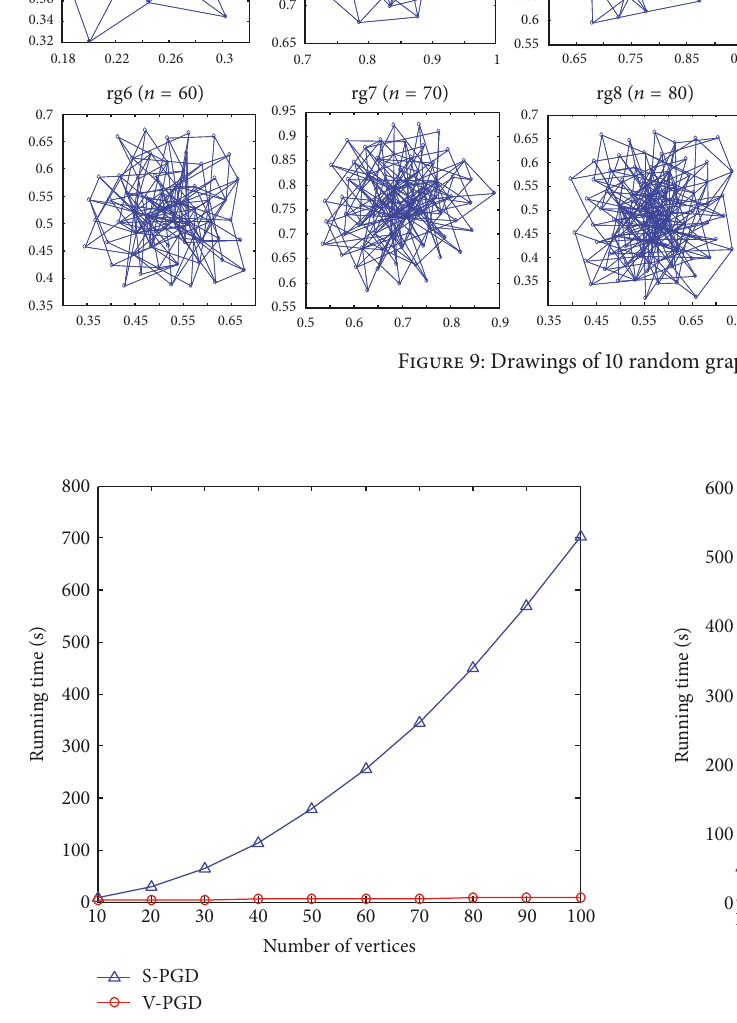
Figure 11: Running time of rg6 ( n = 60 and Itr =